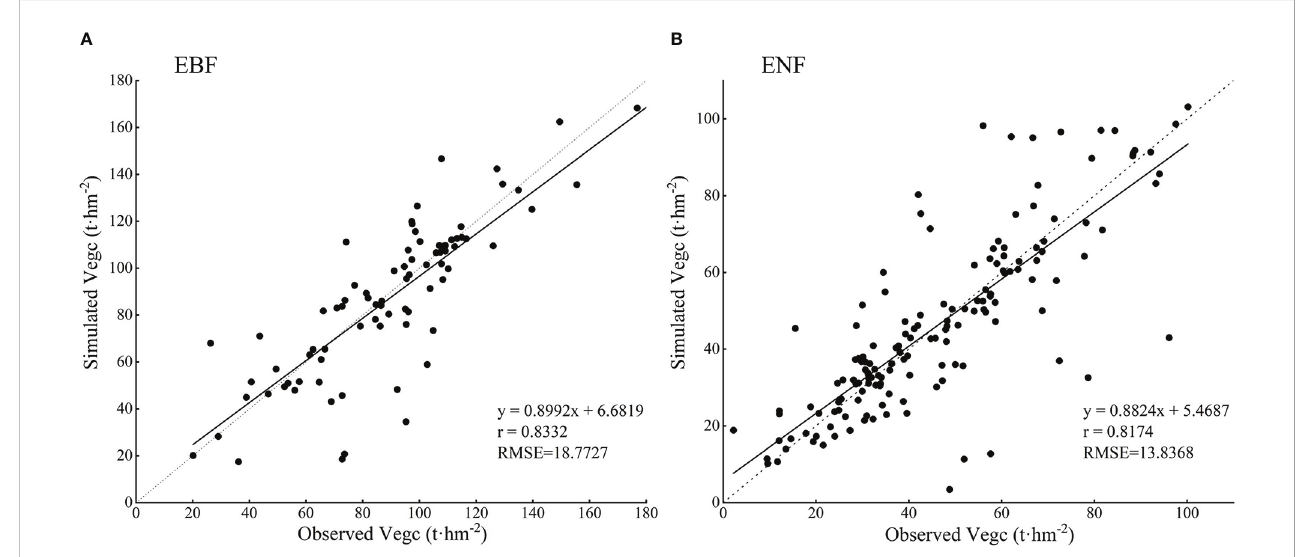
FIGURE 11 The comparison between simulated and observed vegetation carbon storage of two typical subtropical forests in Zhejiang Province ( A . EBF and B .